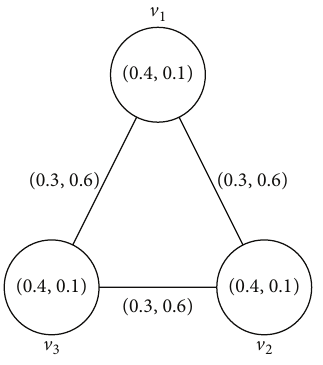
Figure 9: 𝐺 is irregular and totally irregular.